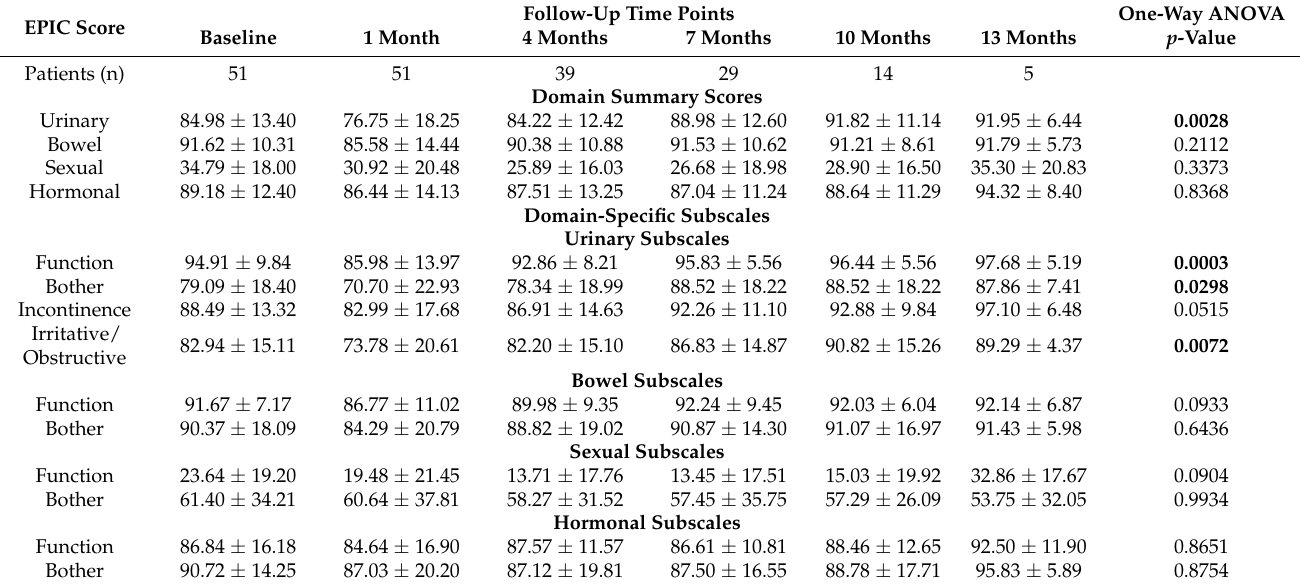
Figure 1. Clinician-reported genitourinary (GU) and gastrointestinal (GI) adverse effects based on the Common Terminology Criteria for Adverse Events Scale (CTCAE) v. 5.0 at different time points. Baseline: before the start of magnetic resonance- guided stereotactic body radiotherapy (MRgSBRT); acute, during MRgSBRT and ≤ 30 days after the completion of MRgSBRT; subacute, >30 days after the completion of MRgSBRT until the last follow-up. Table 3. Patient-reported outcome measurements based on the Expanded Prostate Cancer Index Composite (EPIC)